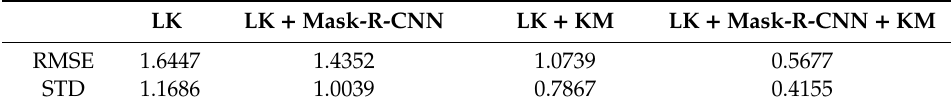
Table 3. Velocity errors of four algorithms in the X direction.